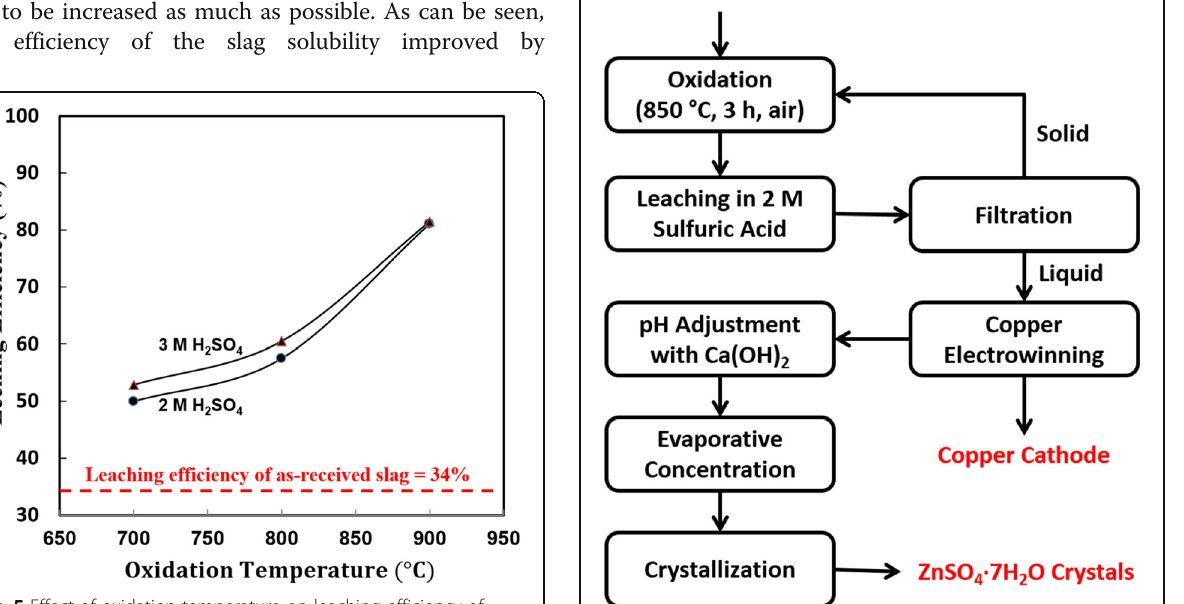
Fig. 6 Proposed flowsheet for the recovery of zinc and copper from the brass